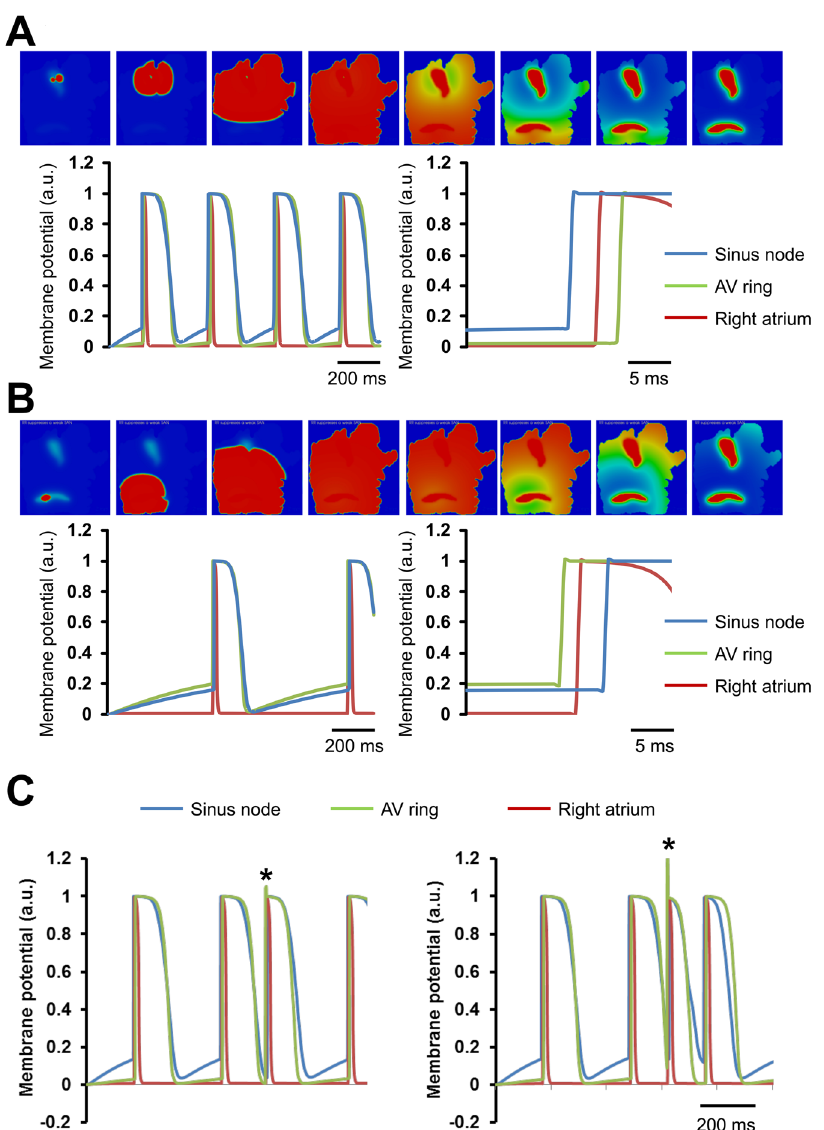
Figure 7. 2D computer simulation. ( A ) Normal activation pattern in the right atrium. Top row, sequential electrical propagation maps showing membrane potentials of cells at each location in the 2D sheet. Blue represents resting potential (0 in case of the Fenton Karma model). Red represents an activated action potential. The dominant pacemaker is at the level of the sinus node and overdrives all pacemaker activity in atrioventricular ring (AV ring). Below, single-cell action potential profiles are shown for sinus node (blue trace), right atrium (red trace) and AV ring (green trace). ( B ) In the diseased sinus node, pacemaker activity is elicited in AV ring and propagates through the atrium and supresses sinus node. ( C ) Two examples of premature ectopic beats arising in AV ring (denoted by * ) causing suppression of pacemaking in sinus node. Horizontal scale bars represent time in